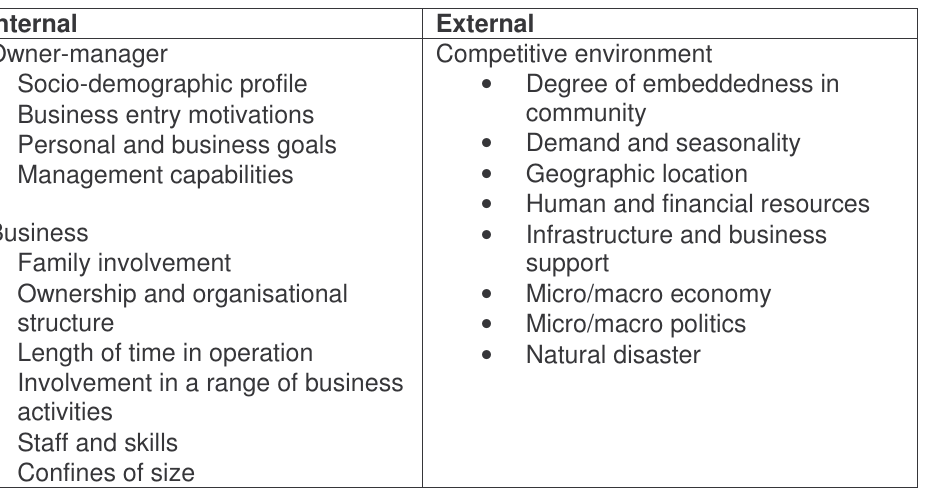
Table 1: Internal and external contextual factors